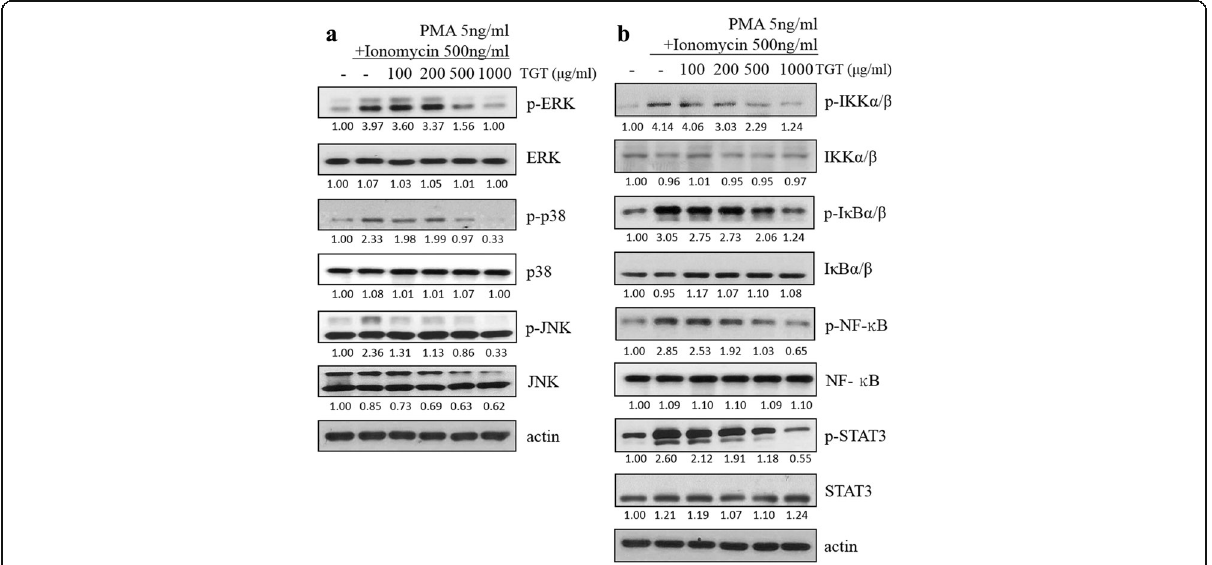
Fig. 3 Effect of TGT on the protein expressions of MAPK and NF- κ B signaling pathways in HMC-1 cells. PI-stimulated HMC-1 cells were treated with or without different doses of TGT for 24 h. The levels of protein expressions of ( a ) MAPK signaling pathway and ( b ) NF- κ B signaling pathway in the whole cell lysates of HMC-1 cells were measured by western blot assays